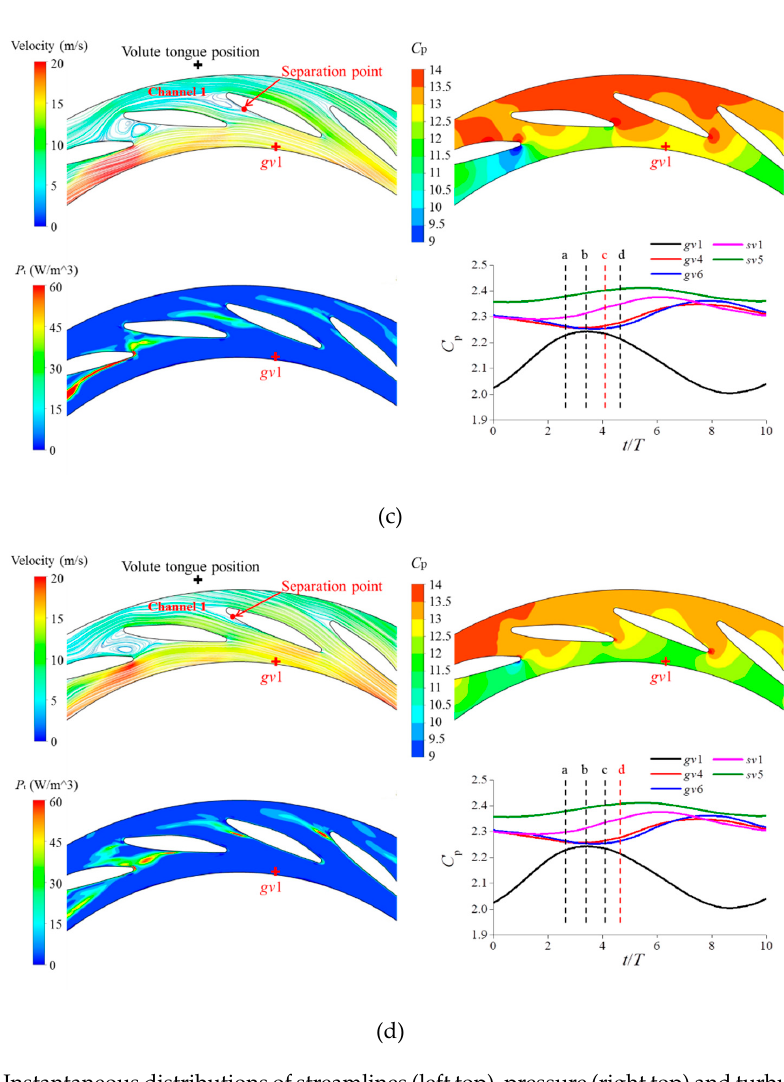
Figure 24. Instantaneous distributions of streamlines (left top), pressure (right top) and turbulent kinetic energy dissipation (left bottom) in guide vane channels at condition V. Subfigures (a)~(d) correspond to the conditions at related time instance.